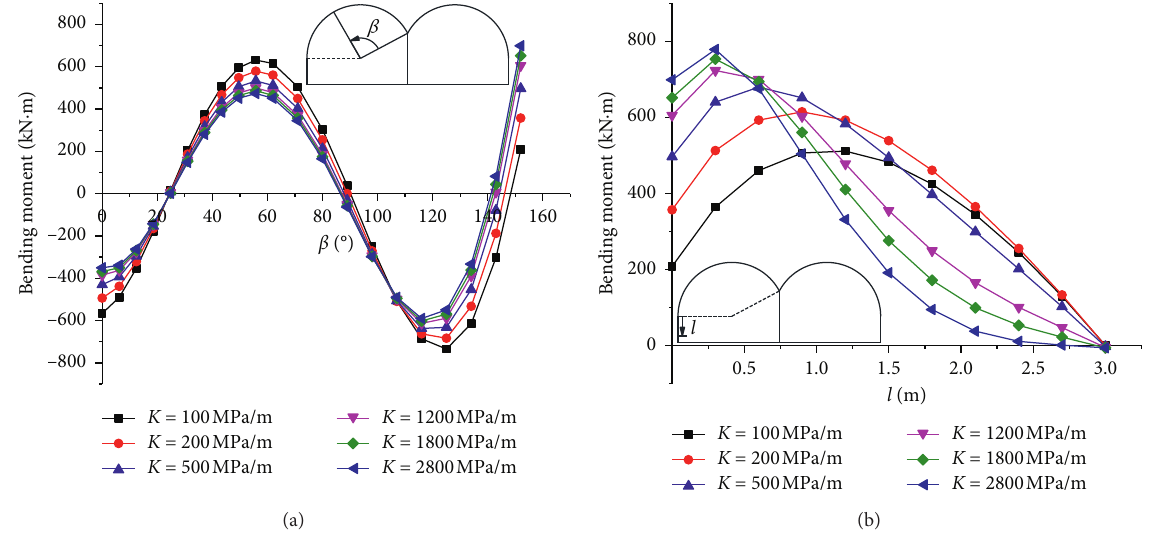
Figure 15: Variations of bending moment with ( K ): (a) along the arch ring; (b) along the side